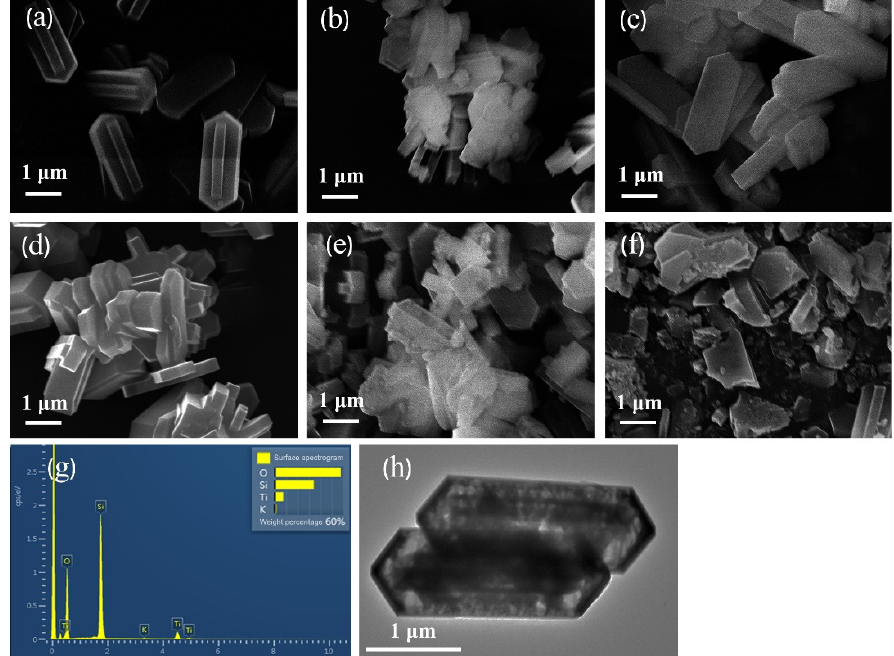
Figure 2. The SEM images of ( a ) TS-1, ( b ) TS-1_P, ( c ) TS-1_0.05K, ( d ) TS-1_P-0.01K, ( e ) TS-1_P-0.05K, ( f )TS-1_P-0.10K, the EDS data of ( g ) TS-1_0.05K, and the TEM image of ( h ) TS-1_0.05K.